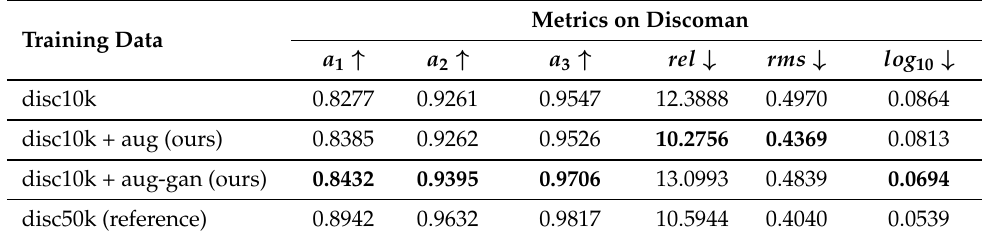
Table 5. Comparison of depth estimation metrics, when trained on various original and post- processed combinations of DISCOMAN data. Numbers in bold indicate the best result in the